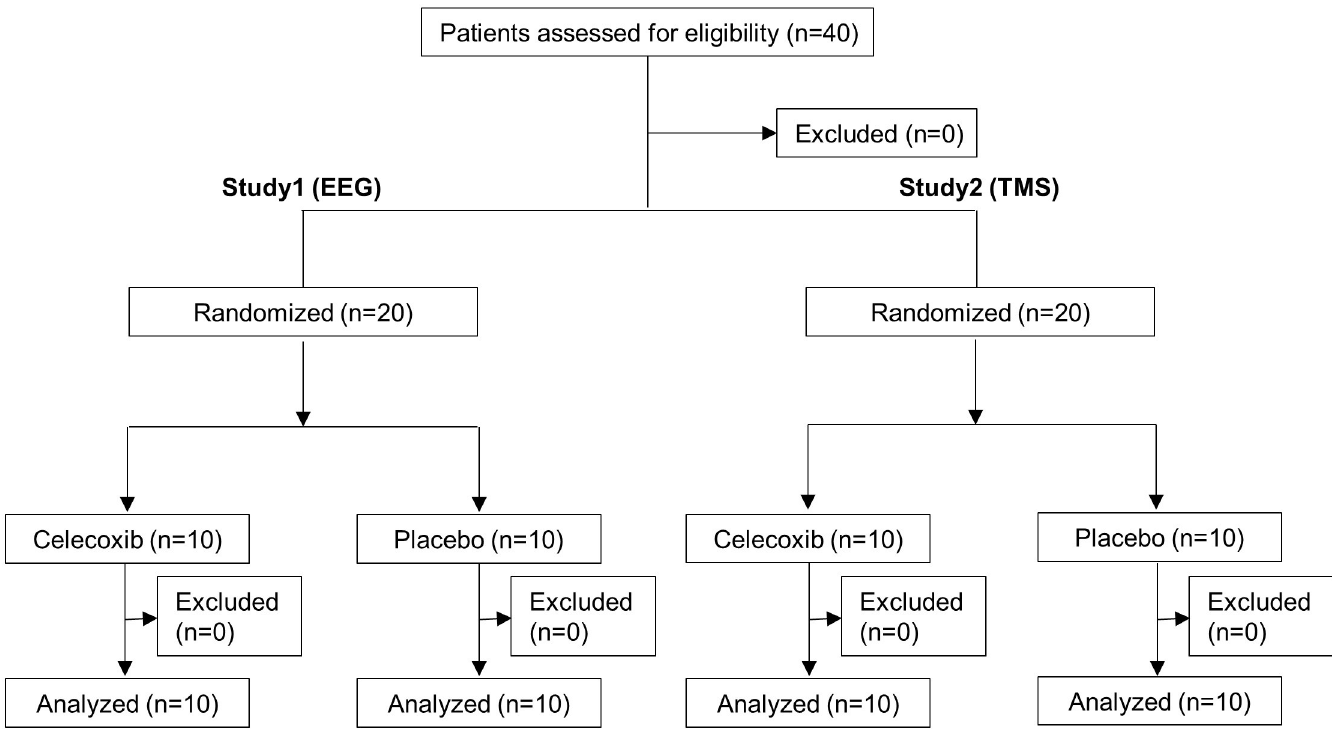
Fig 1. Study flow diagram. Abbreviations: EEG = electroencephalography, TMS = transmagnetic stimulation.